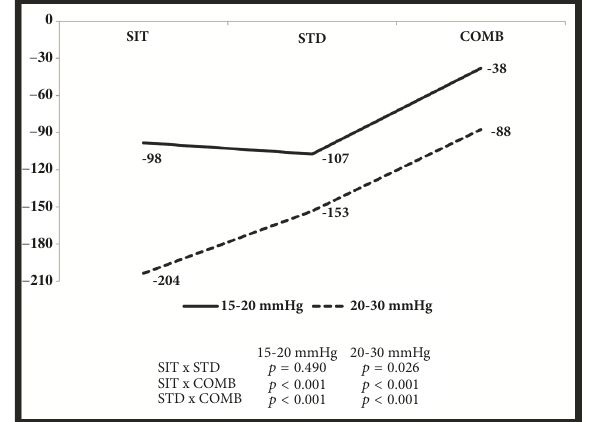
Figure 3: Graphic representation of the mean volumetric variations afteraworkingdayusing15-20mmHg(secondday)or20-30mmHg (third day) compression